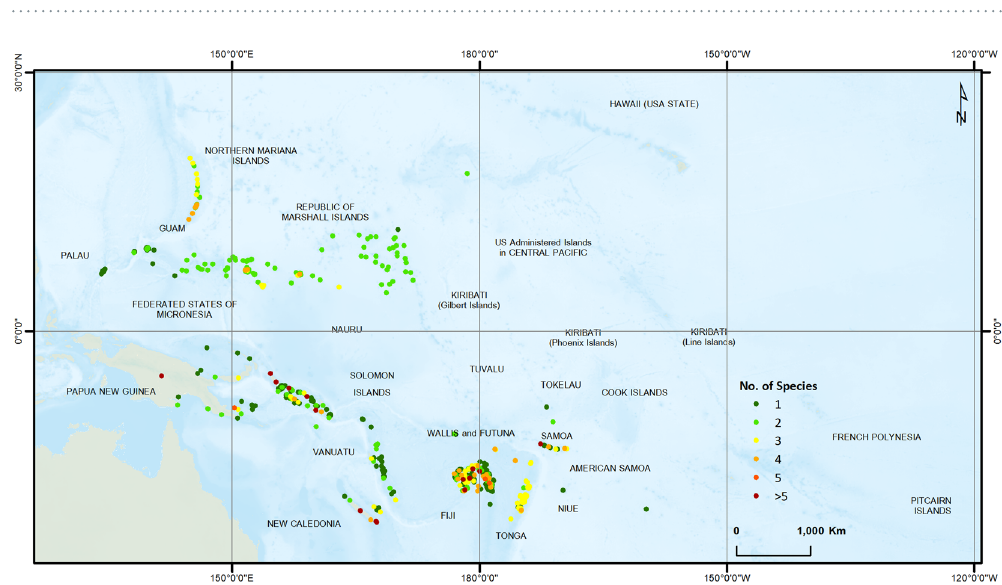
Figure 3. Species types hosted by each of the islands. (Figure generated using ARCGIS 10.3, http://www.esri. com/).